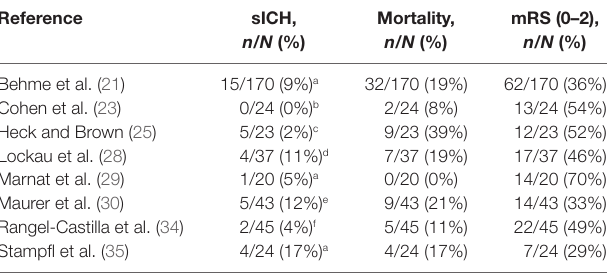
taBLe 4 | Outcomes of included studies investigating patients with ischemic stroke caused by a “tandem lesions” who underwent acute mechanical thrombectomy with or without emergency extracranial carotid stenting, who received periprocedural antithrombotic drugs as protocol-based care.